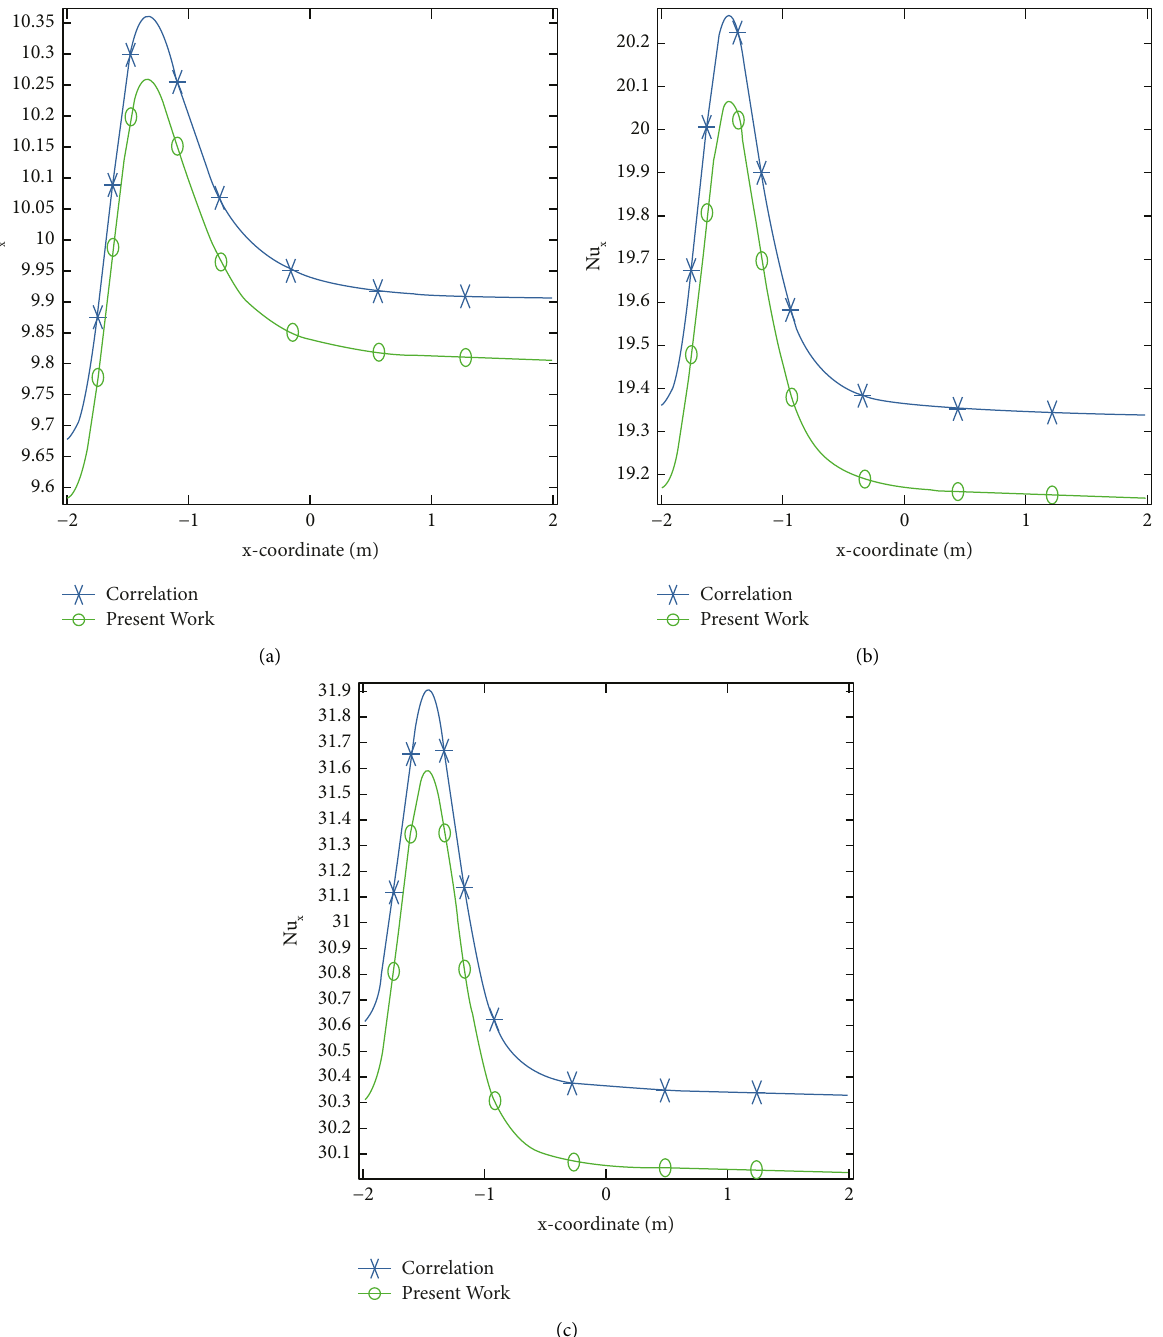
Figure 4: The comparison of local Nusselt number’s correlation with the present work: (a) Re � 1000, r � 0.1, and n � 0.8; (b) Re � 4000, r � 0.1, and n � 0.8; (c) Re � 10,000, r � 0.1, and n � 5.1. Pressure Distribution. Pressure contour plots for the flow past the cylinder with radius r � 0 . 1 m are displayed in Figure 7 for different values of the Reynolds number and the flow behaviour index. In Figure 8, we put into view the similar graphs by setting r � 0 . 2 m. Impact of the three parameters over pressure distribution on the front and back surface of the cylinder is very clear from these two figures. Pressure increases with the increasing value of the Reynolds